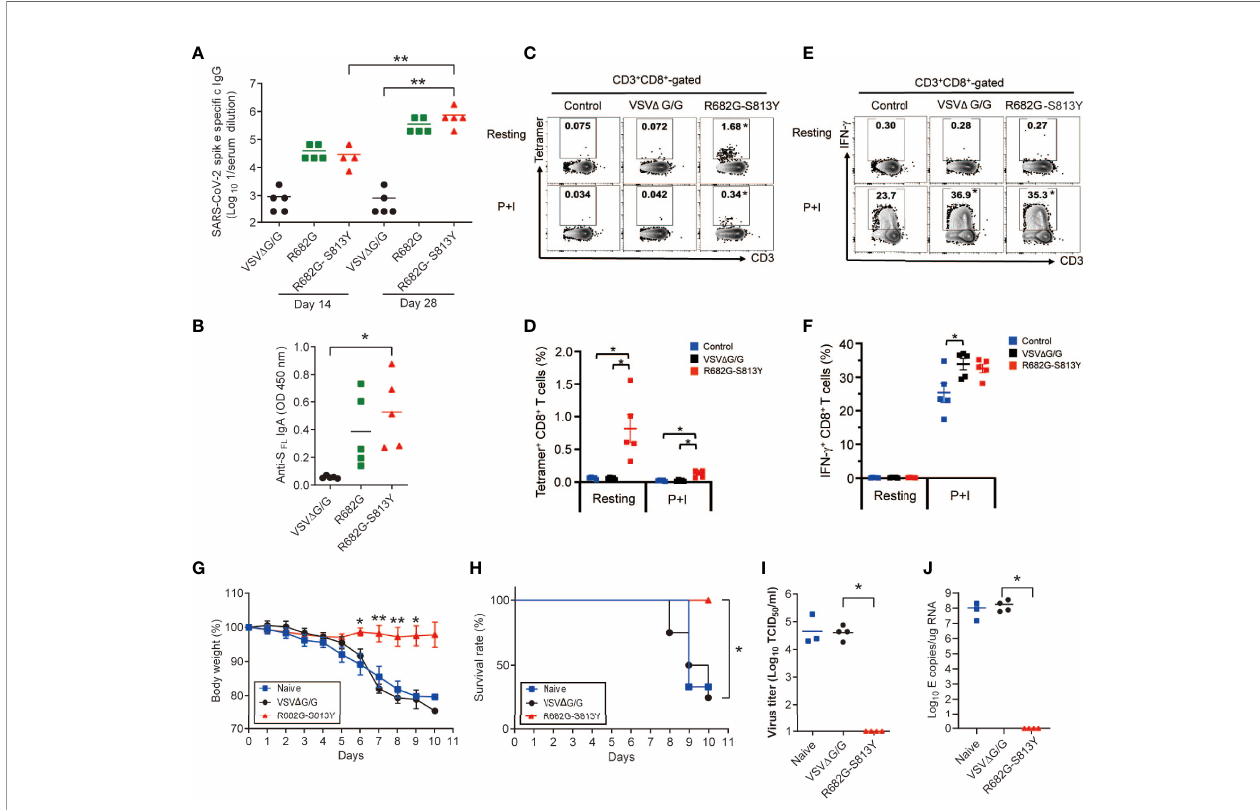
FIGURE 8 | The S D 19 Rep (R682G-S813Y)-vaccinated hACE2 transgenic mice were protected from the SARS-CoV-2 lethal infection. (A) K18-hACE2 transgenic mice were vaccinated with VSV D G/G (control virus), S D 19 Rep-R682G, and S D 19 Rep-R682G-S813Y twice on Day 0 and Day 21 (i.n.; 1×10 8 pfu or ffu/mouse; n=5). Anti-S FL IgG titer in the serum samples collected on Day 14 and Day 28 was measured by ELISA. (B) Anti-S FL IgA titer in Nasal lavage fl uid (Day 35) was detected by ELISA. (C – F) Splenocytes were isolated on Day 35-post vaccination and stained with T cell markers and the H-2K(b) SARS-CoV-2 S Tetramer for fl ow cytometry. Some splenocytes were treated with PMA (50 ng/ml) and ionomycin (500 ng/ml) for 5 h to activate T cell (P+I). (G – J) The vaccinated-mice were challenged with the SARS-CoV-2 Delta strain (1000 TCID 50 /mouse; i.n.; n=6-8). Mouse body weight loss (G) and survival rate (H) were monitored. Half of the infected-mice were sacri fi ced, and the virus titer (I) and viral RNA level (J) in the mouse lung were measured. * P < 0.05; ** P <